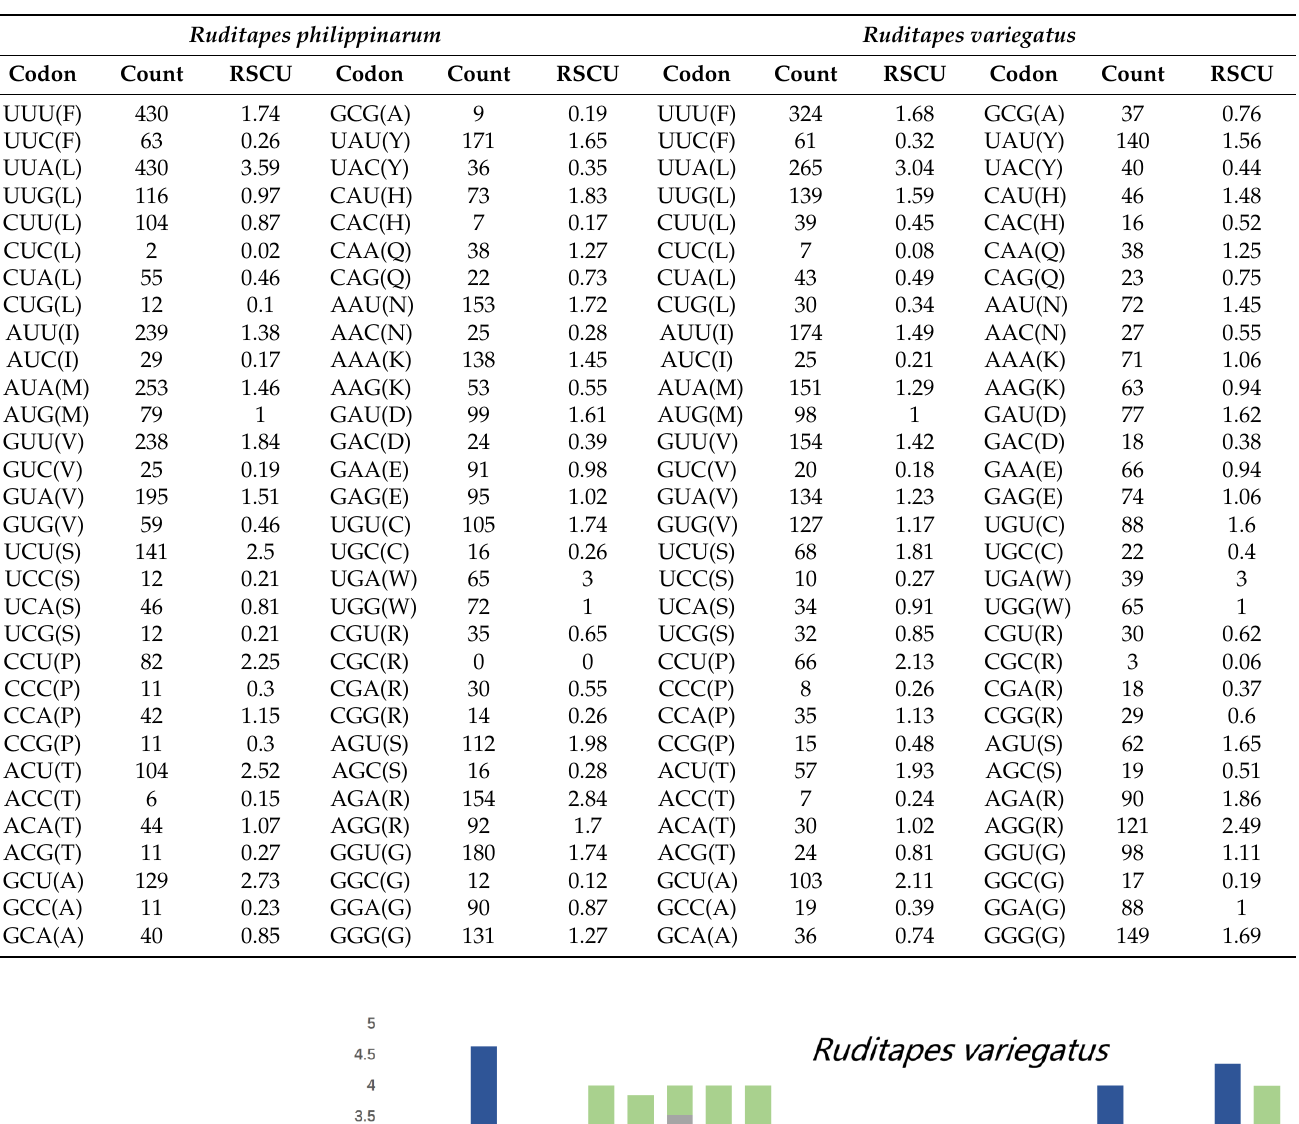
Table 8. Codon number and relative synonymous codon usage (RSCU) in the mitochondrial genomes of Ruditapes philippinarum and R. variegatus .